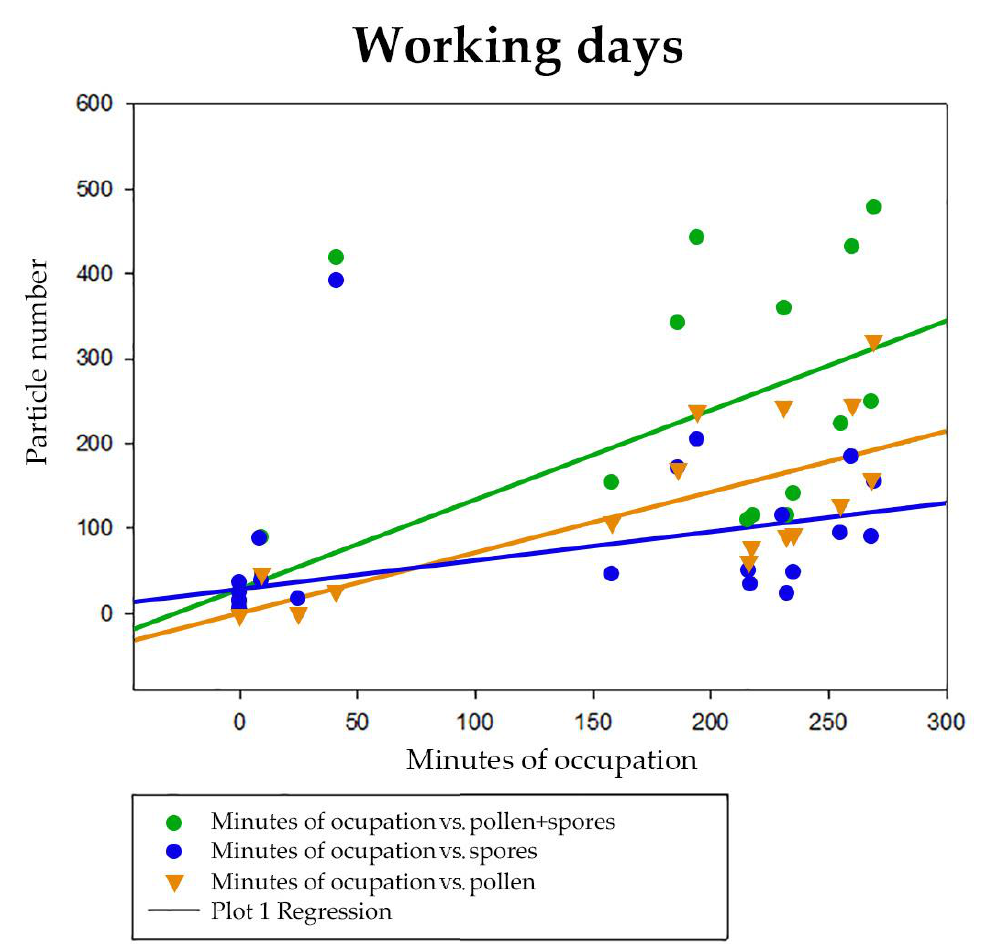
Figure 9. Regression analysis (R 2 = 0.741) between minutes of occupation of the room and, respectively, pollen + spores ( p < 0.001), spores ( p < 0.001) and pollen (highly collinear). Degrees of freedom = 31.